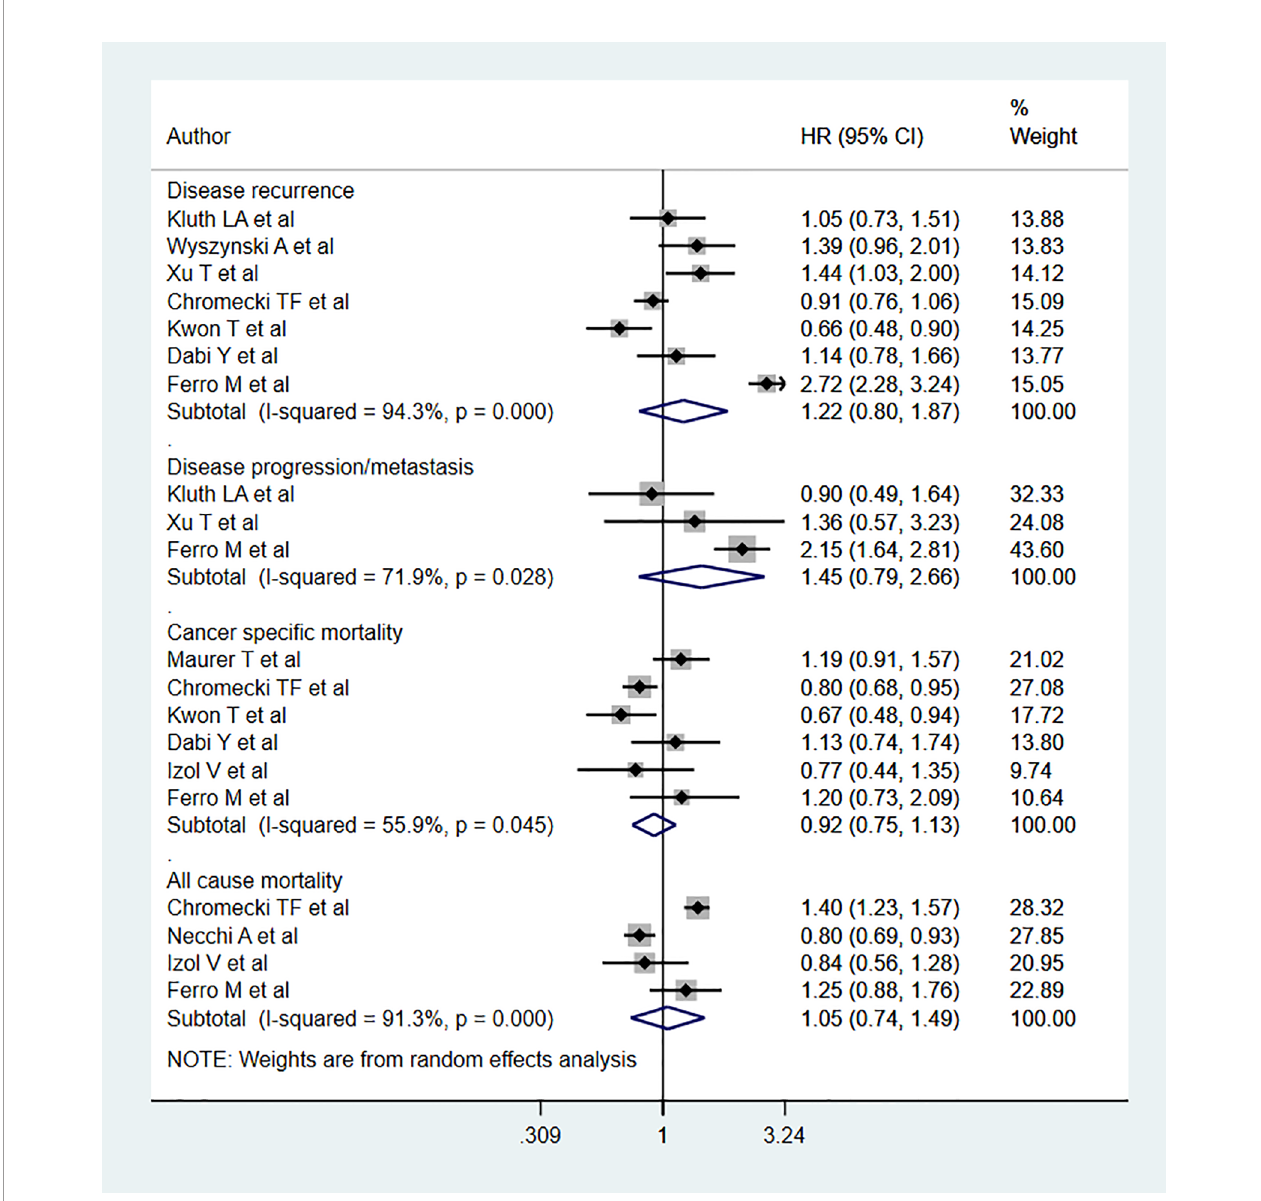
FIGURE 3 | Bladder cancer patient outcomes in overweight and normal BMI